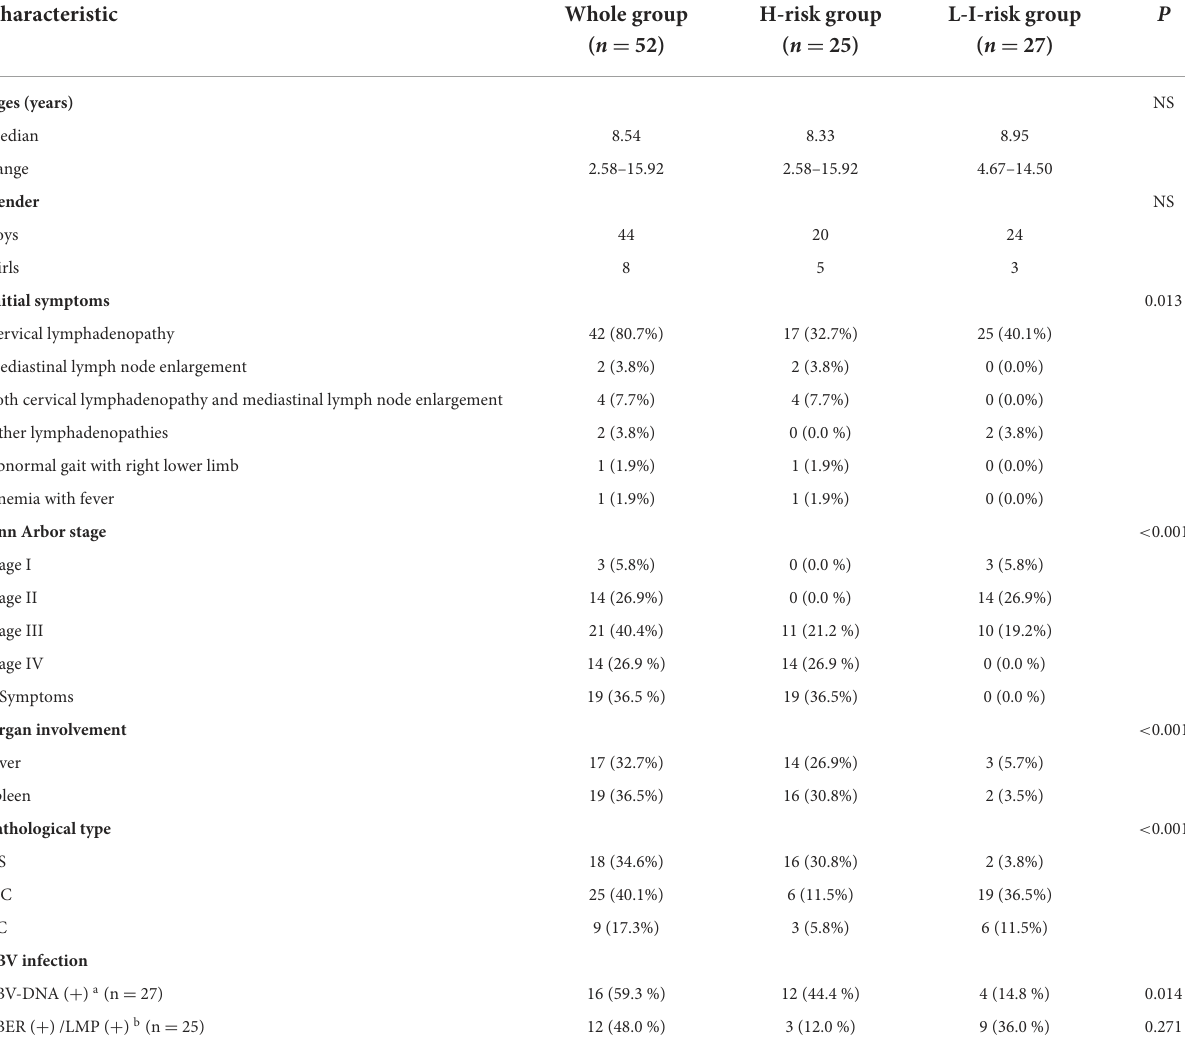
TABLE 1 Clinical characteristics of children with